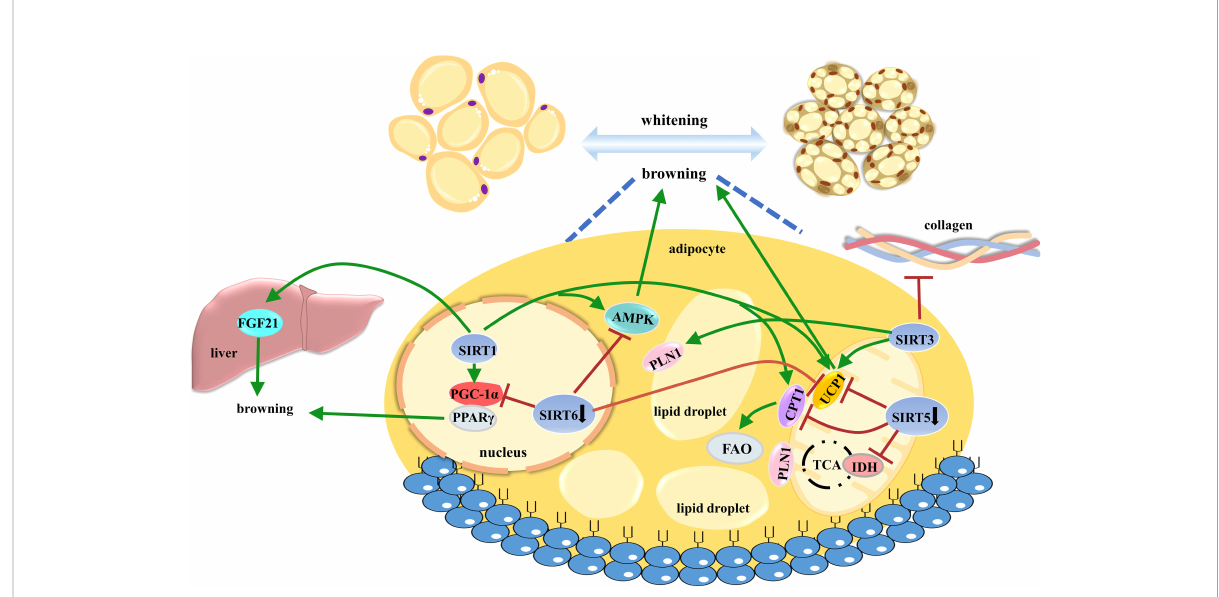
FIGURE 4 The roles of SIRT1, SIRT3, SIRT5, and SIRT6 in controlling AT browning. AT browning is a promising anti-obese strategy to enhance energy expenditure through heat production. Sirtuins widely participate in beige cell differentiation and function. AT, adipose